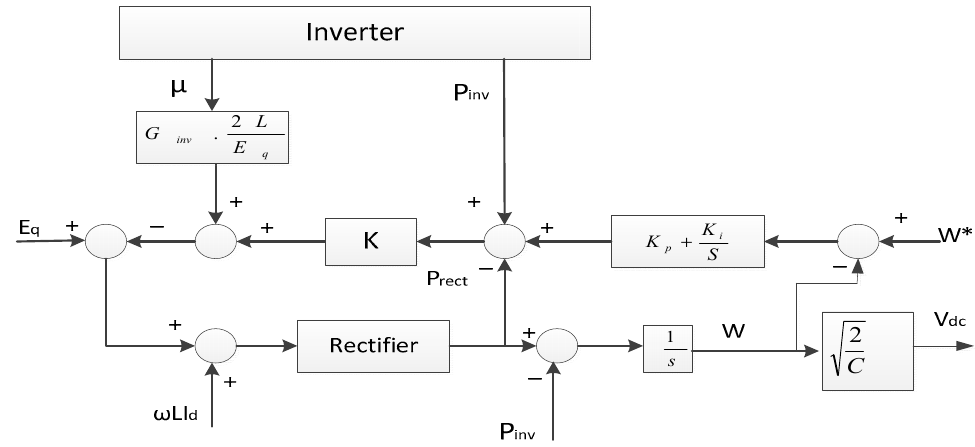
Figure 12. A schematic diagram of the power control system.